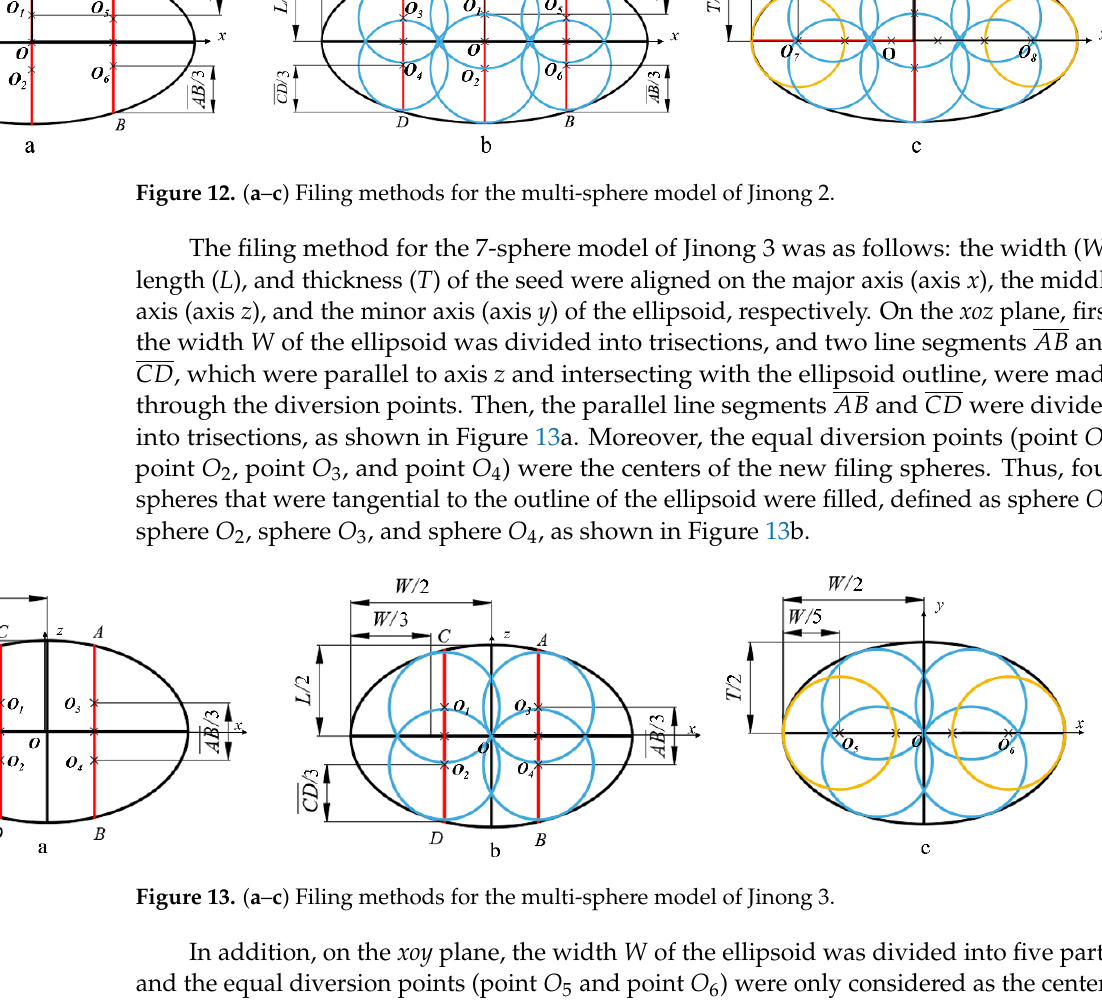
Figure 14. ( a – i ) Multisphere models for different varieties of Cyperus esculentus seeds. 4.2. Contact Force Model of Multi-Sphere Particles As a partial sphere a in a multi-sphere particle z , a normal force and a tangential force which were acting on partial sphere a at the contact point p, given as: 3 2 4